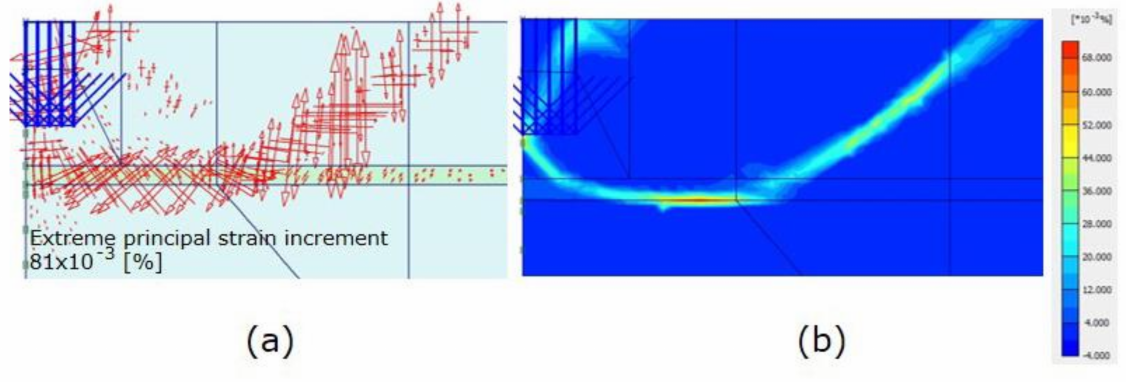
Figure 7. Incremental strains at failure for the case in which the sand has ϕ (cid:48) 1 = 40 ◦ and ψ (cid:48) 1 = 15 ◦ , while the weak layer is characterised by ϕ (cid:48) 2 = 10 ◦ and ψ (cid:48) 2 = 0; the depth of the weak layer is z i /B = 1.5. ( a ) principal directions; ( b ) shear shadings.